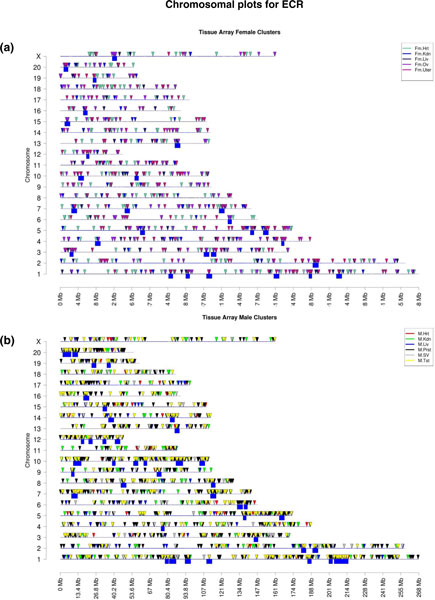
Chromosomal locations of differentially expressed genes. (a) Chromosomal plot of
differential gene expression (arrow head) and ECRs (box) for five female tissue types (heart,
kidney, liver, ovaries and uterus). (b) Chromosomal plot of ECRs for six male tissue types
(heart, kidney, liver, prostate, seminal vesicle and testis). (c) Chromosomal plot showing
clustering of male tissues and female tissues. Insets show tissue identification color code. F,
female; M, male; SV, seminal vesicle.